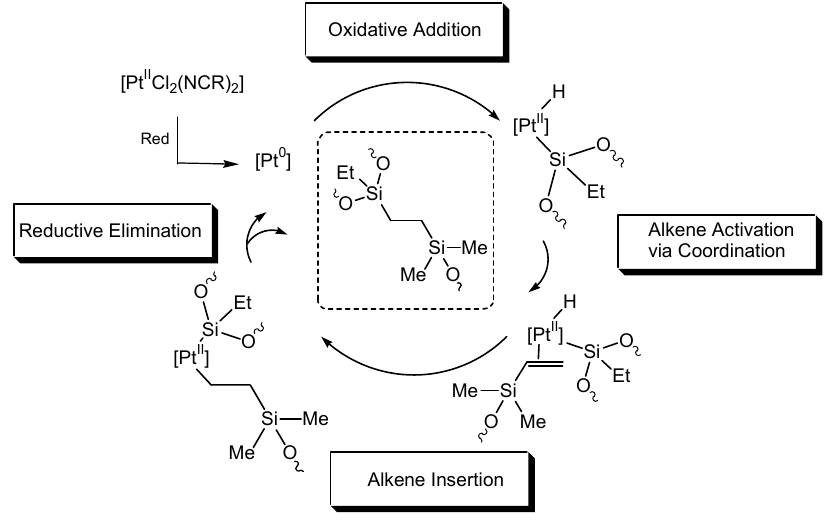
Scheme 2. Plausible mechanism of the cross-linking.